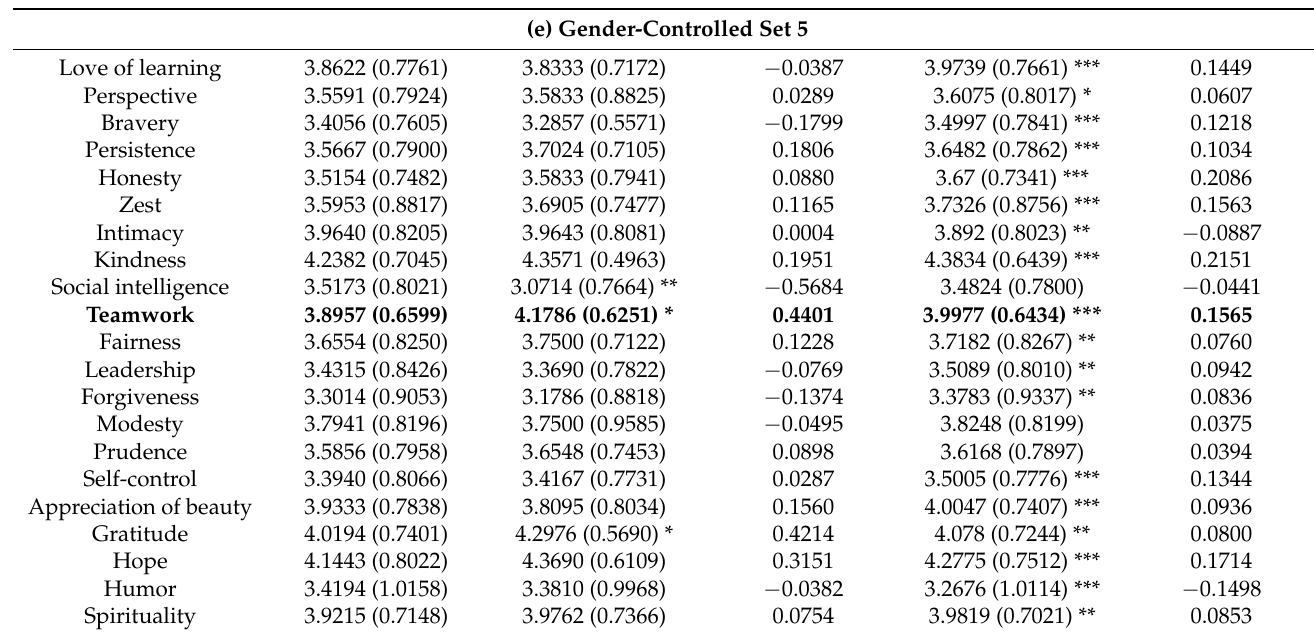
Table A1. Cont. (e) Gender-Controlled Set